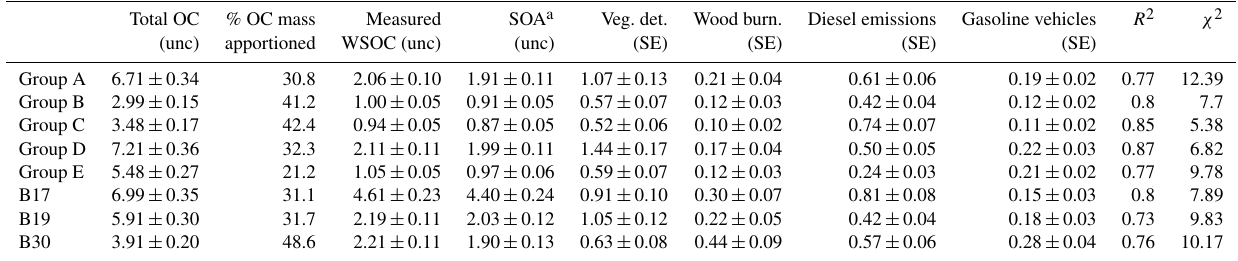
Figure 9. Molecular marker analysis results from the PM 10 filter samples, presented by filter groups, where GRA is group A, GRB is group B, etc. and B17, B19, and B30 are individual filters. More information on the filter groups, including some basic composition information and back trajectory origin, can be found in Table 3. Table 4. Chemical mass balance source apportionment results. Units are µgm − 3 unless otherwise noted. Uncertainty is measurement uncer- tainty, in the case of SOA propagated uncertainty, and SE is standard error for the source categories. Total OC % OC mass Measured SOA a Veg. det. Wood burn. Diesel emissions Gasoline